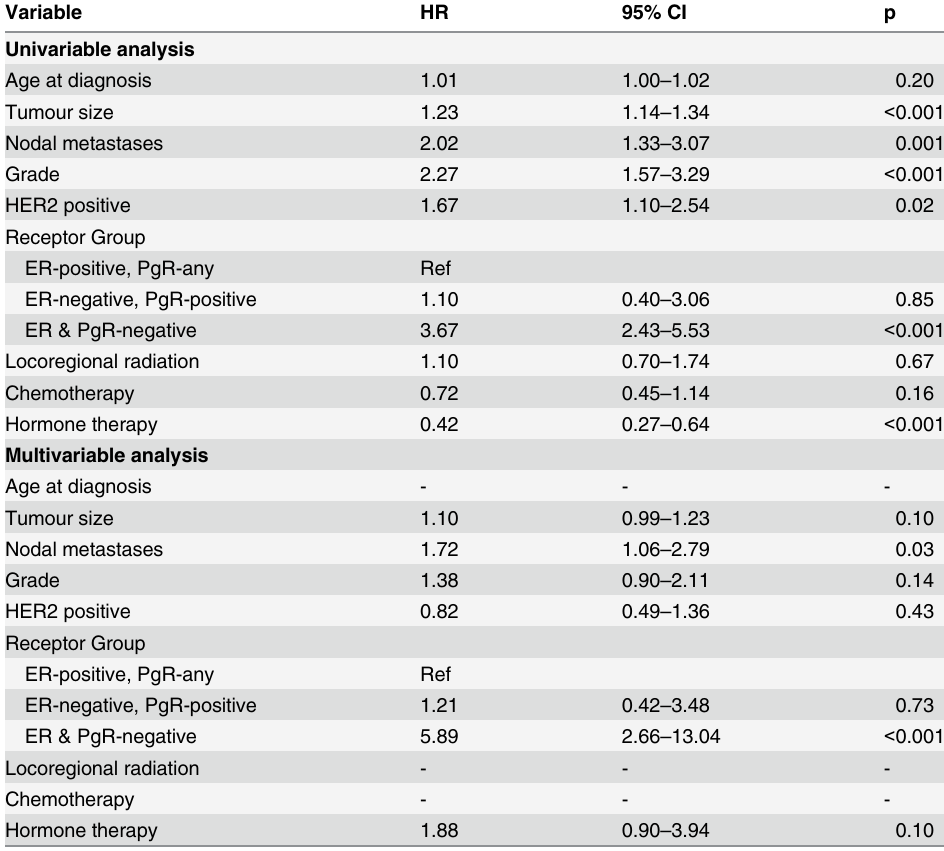
Table 4. Univariable and multivariable analyses for overall